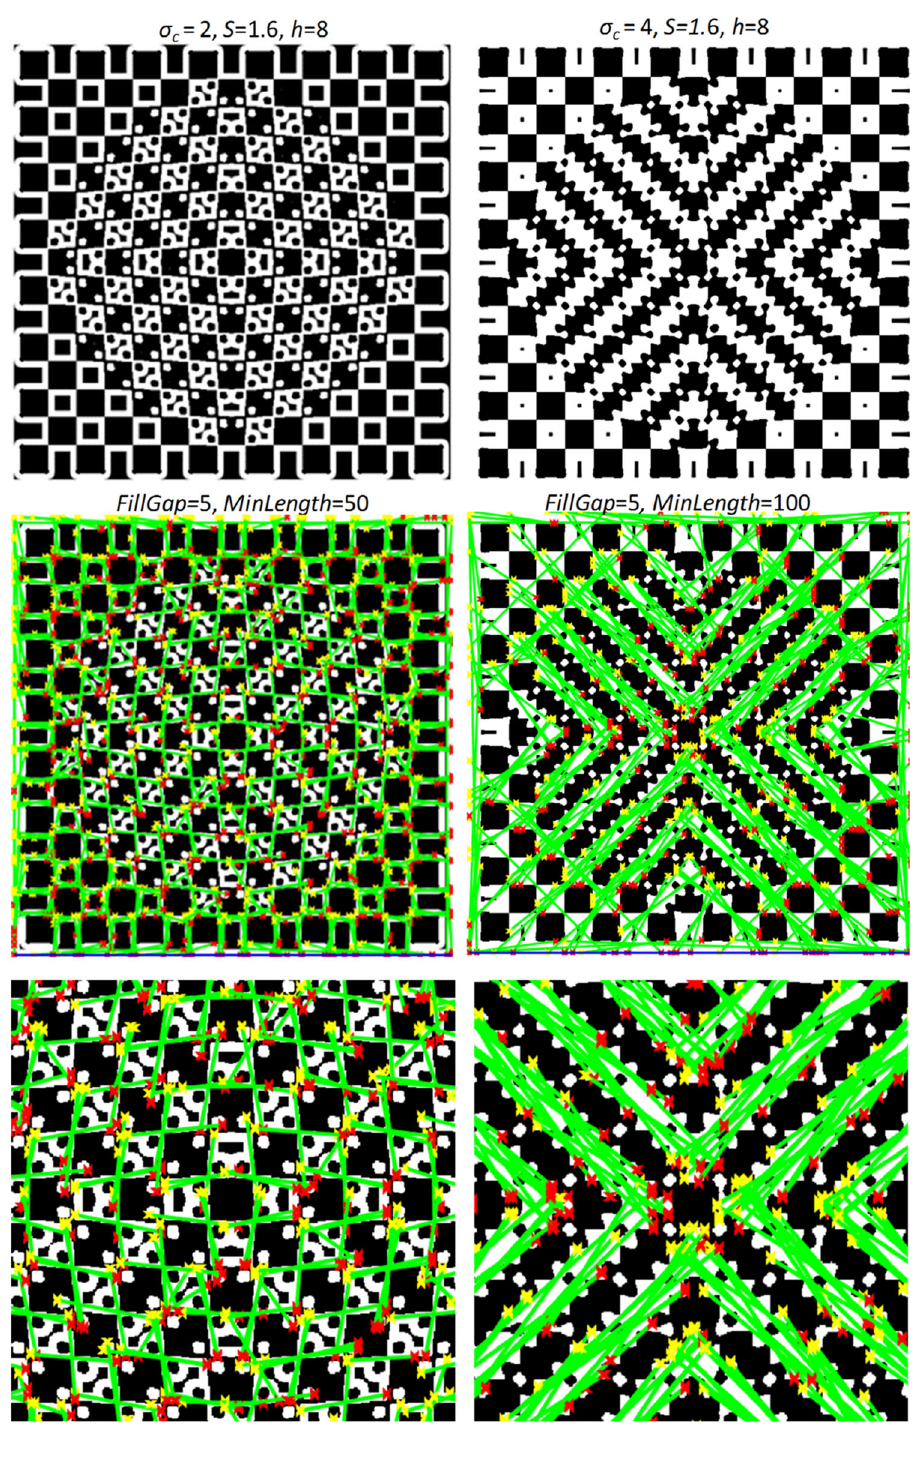
Fig. 7 Detected houghlines ( centre ) for two scales of 2 and 4 ( r c ¼ 2 ; 4) from the edge map of the Complex Bulge pattern ( top ). The two images at the bottom of the figure are zoomed-in versions of the two images at the centre row . The parameters of the model and Hough investigation have been provided on the figure (Reproduced by permission from [145]). (Color